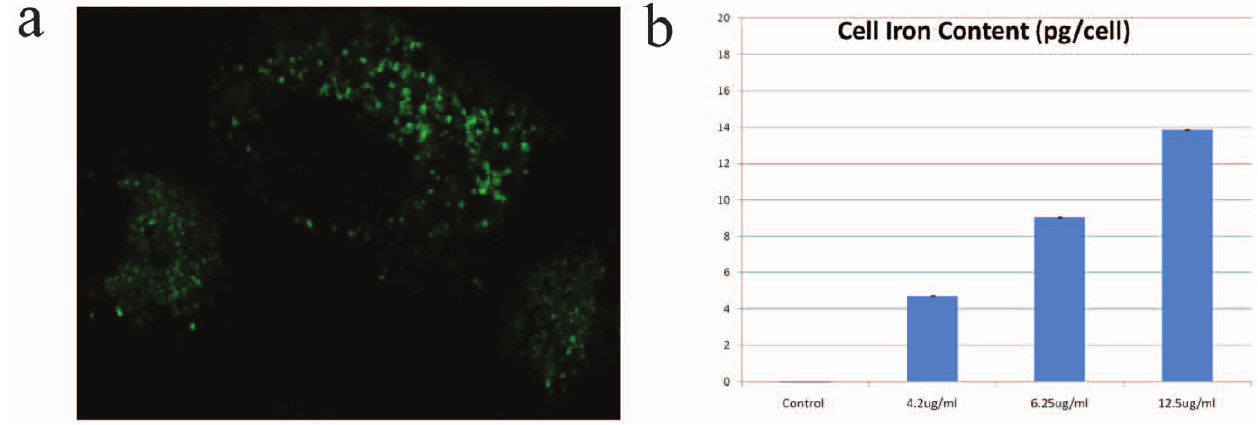
Figure 2. Magnetic content and nanoparticles localization of labeled HeLa cells. a) Fluorescence Image (40 6 ) of a HeLa cells after incubation with dyed magnetic nanoparticles at an extracellular iron concentration of [Fe]=12.5 ug/ml (0.22 mM). b) Cellular iron content in picogram per cell. The concentrations of particles in the media are given in iron concentration (error bars values represent mean + / 2 0.5*s.d., n=3).